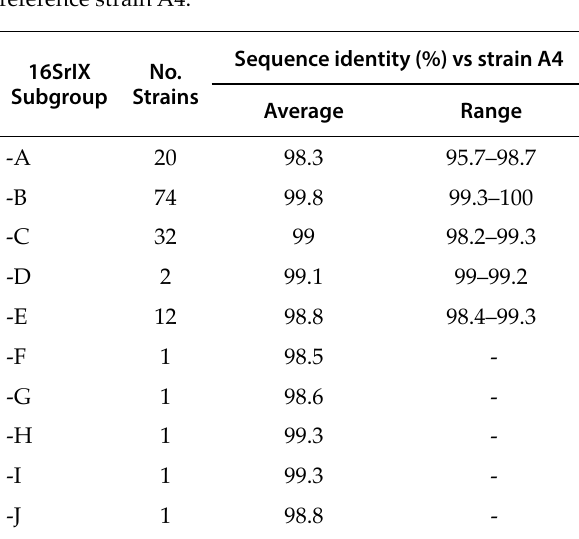
Table 3. 16S rDNA nucleotide sequence identity (%)